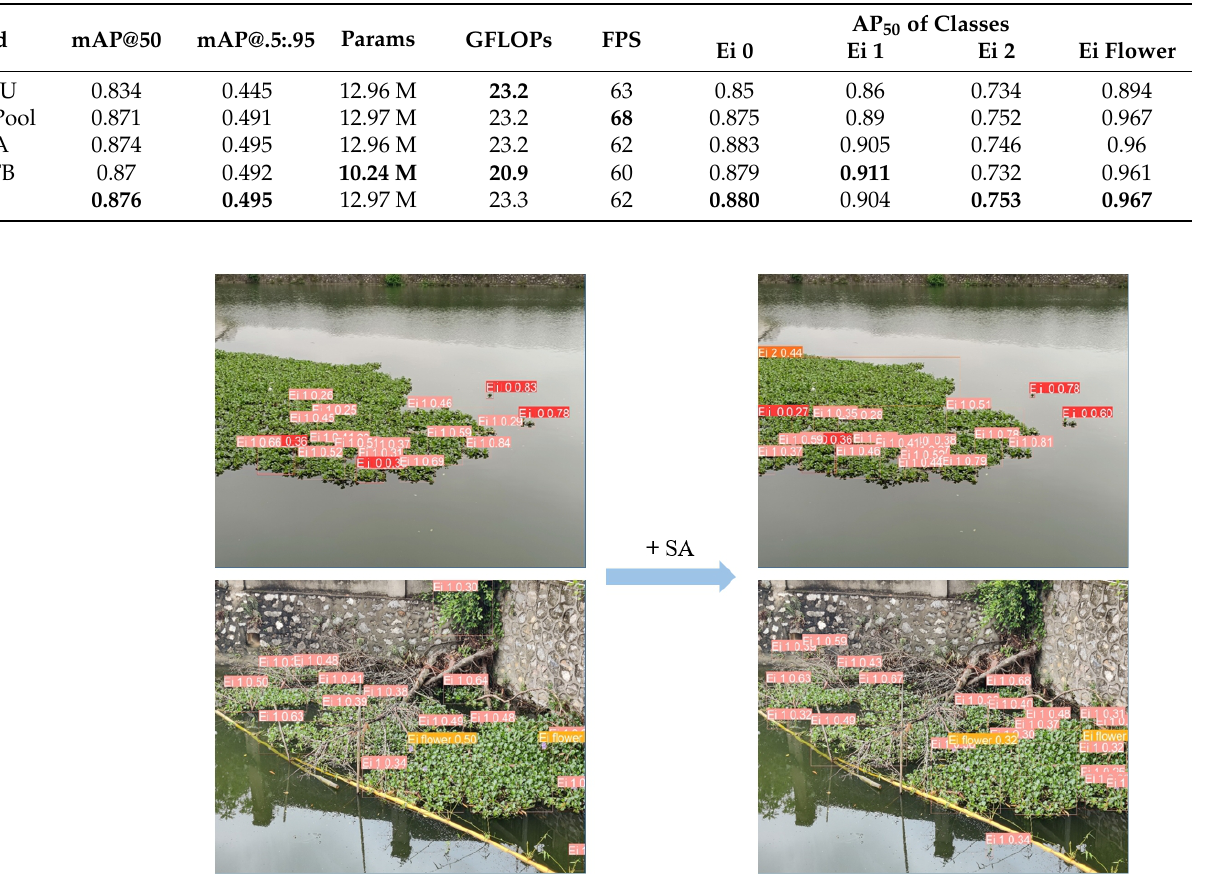
Figure 14. Comparison of detection effects before and after using the SA attention mechanism.